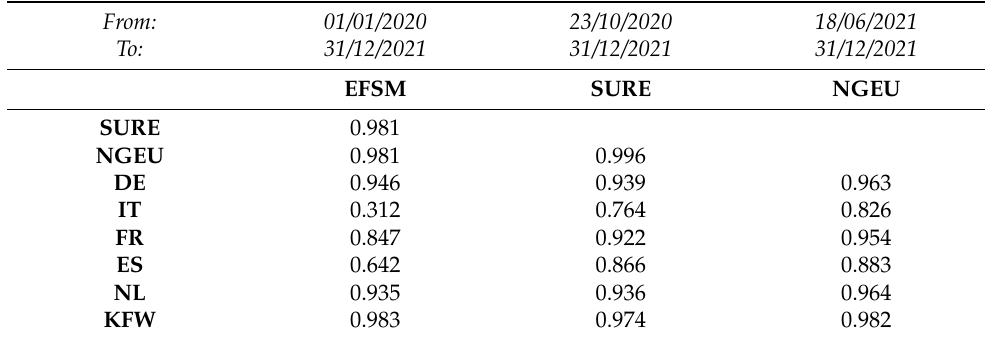
Table 2. Correlations between yield changes. Spearman correlations between changes in yields-to- maturity of ten-year bonds for selected euro area issuers.